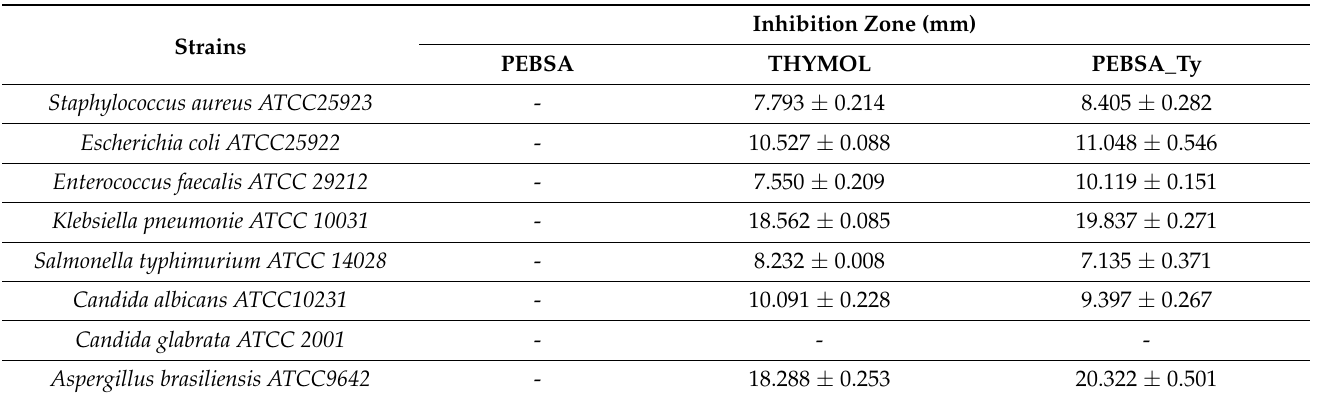
Table 2. Antimicrobial activity of the tested compounds against the references strains (mm). Strains